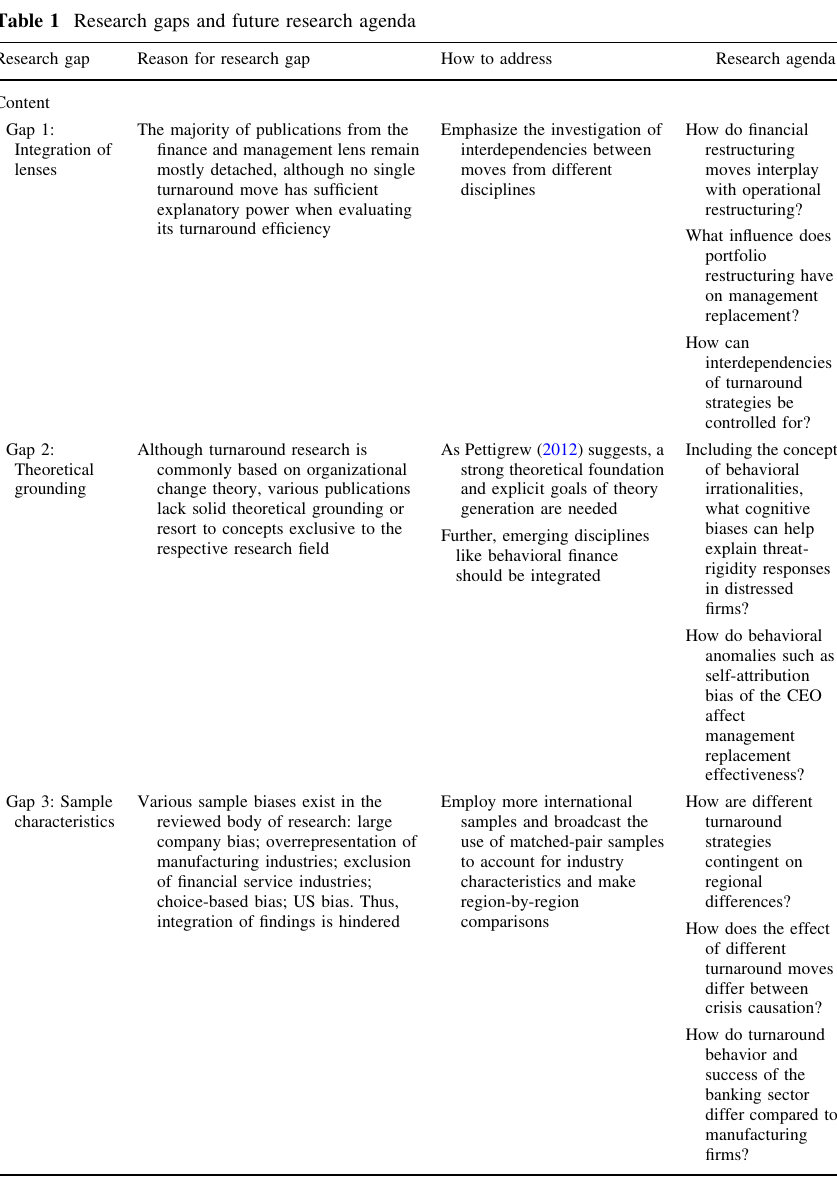
Table 1 Research gaps and future research